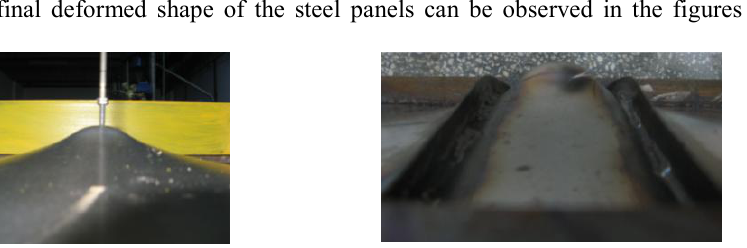
Fig.7 Final plastic deformation - model 1 Fig.8 Final plastic deformation - model 2 Fig.2 Spherical bulb acting on the panel Fig.1 Experimental stand